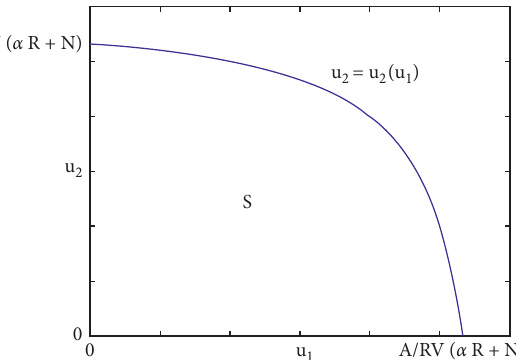
Figure 1: The stability region of E parameters of expenditure u 1 , u 2 .